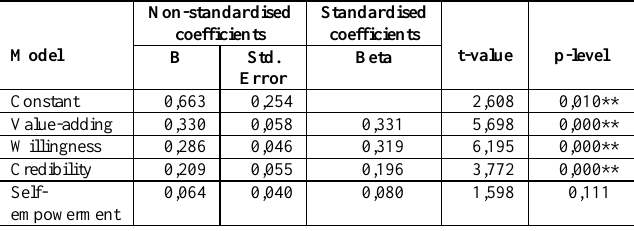
Table 3: Multiple regression results: Impact of value- adding, willingness, credibility and degree of self- empowerment of the younger generation on